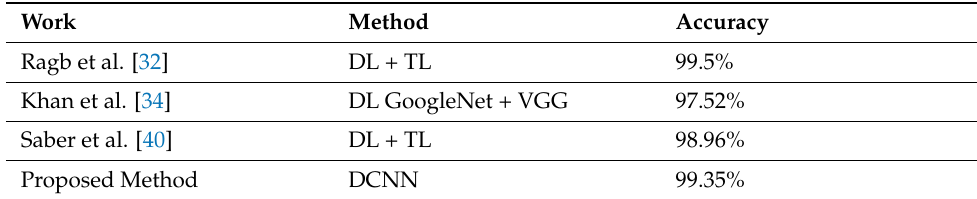
Table 7. Comparison with state of the art work.